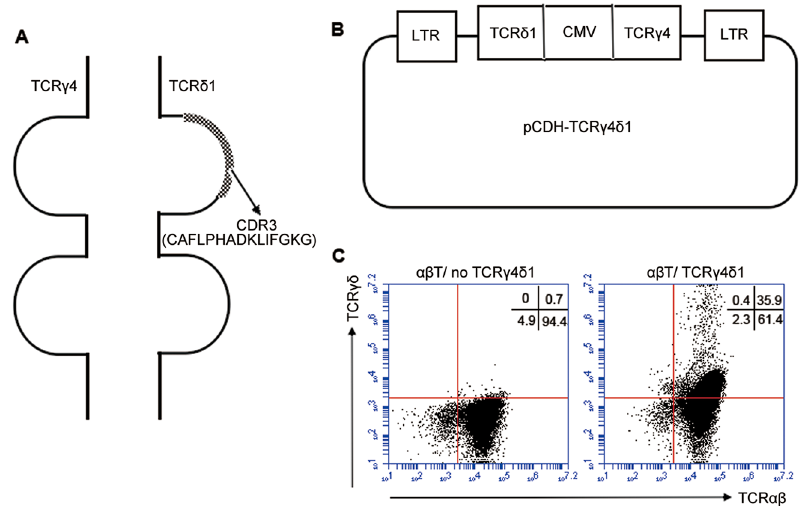
Figure 1. The lentiviral vector efficiently transduced TCR g 4 d 1 into peripheral blood–derived αβ T cells. (A) Schematic diagram of TCR γ 4 δ 1 receptor. The V region of TCR d 1 was ampli- fied using RNA from the γδ TILs of gastric carcinoma tissues by RT-PCR. A high-frequency CDR3 δ 1 sequence, termed GTM, was identified by sequence analysis. The full-length TCR δ 1 with GTM and TCR γ 4 chains were amplified from cDNA of one case of gastric tumor– derived γδ TILs by PCR and paired to form TCR g 4 d 1 . (B) Schematic diagram of the lenti- viral vector containing the TCR d 1 and TCR g 4 genes. The TCR d 1 and TCR g 4 genes